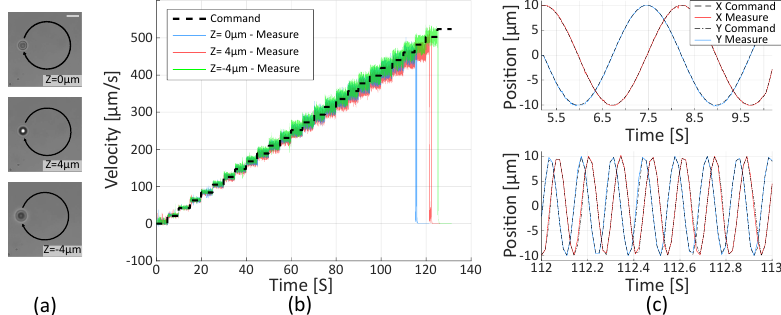
Figure 5. Teleoperated rotation in velocity mode of one micro-bead at different Z positions. ( a ) Pictures of a trapped bead in three different axial configurations. Scale bar is 5 µm long. ( b ) Velocity reference and measured velocity in three different configurations ( c ) X and Y positions of the Trap 1 in “Z = 0 µm” configuration at a speed of 21 µm/s and 462 µm/s. The maximal reachable velocity without losing the traps is 462 µm/s with an error of